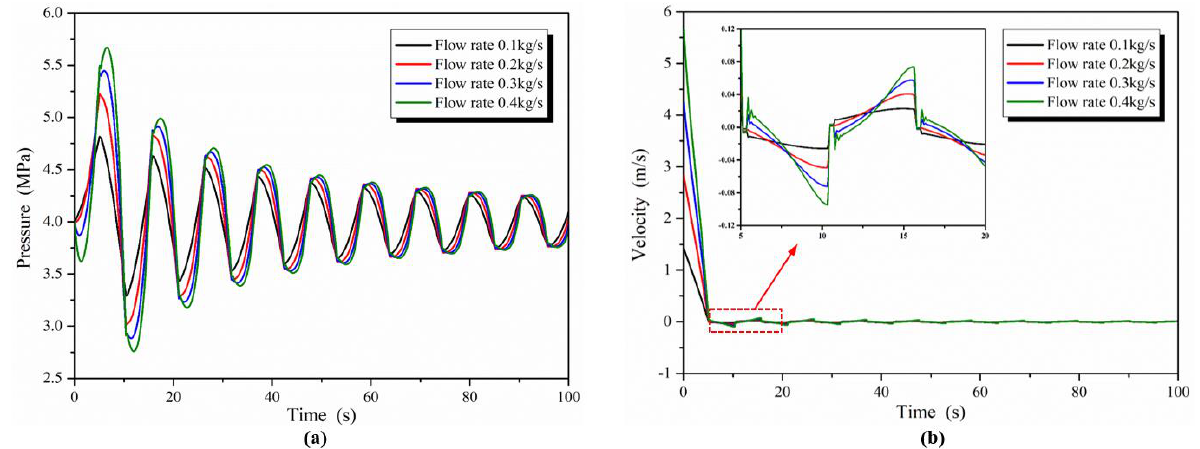
Figure 9. Influence of flow rate on pressure and velocity fluctuation at the end of a pipeline: ( a ) represents pressure response; ( b ) represents velocity response.